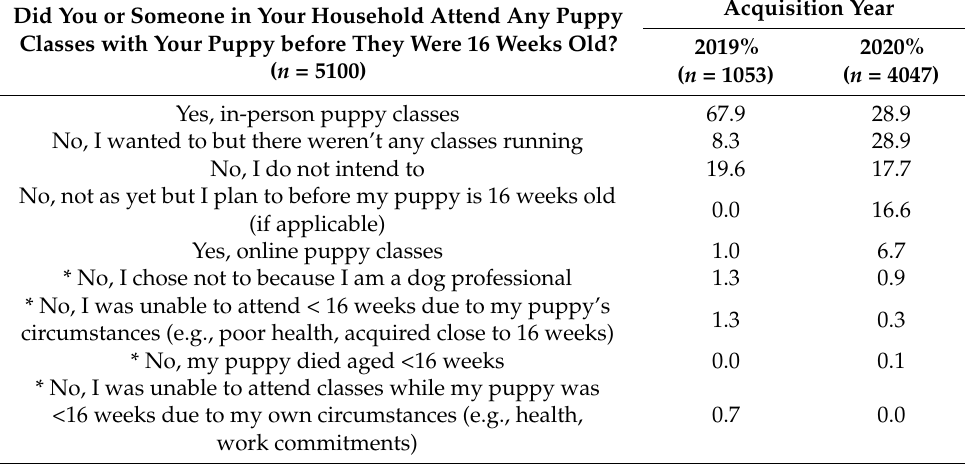
Table 10. Proportion of 2019 puppies ( n = 1053) and Pandemic Puppies ( n = 4047) attending puppy classes under the age of 16 weeks. * Response options shown here were formulated via qualitative content analysis of the free-text option “No, other (please describe